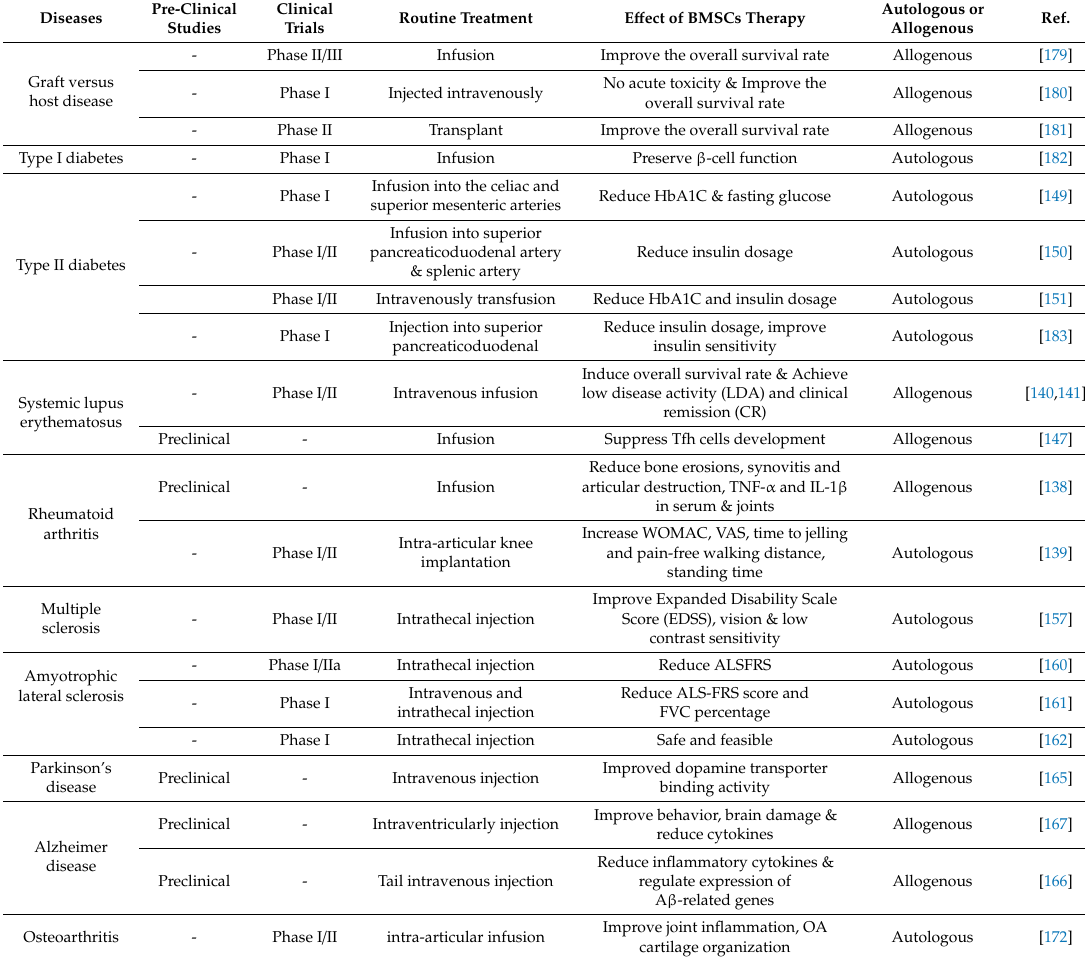
Table 4. Preclinical studies and clinical trials of bone marrow stem cells (BMSCs) applications. Clinical ff ect of BMSCs Therapy Autologous or Allogenous Trials Routine Treatment E